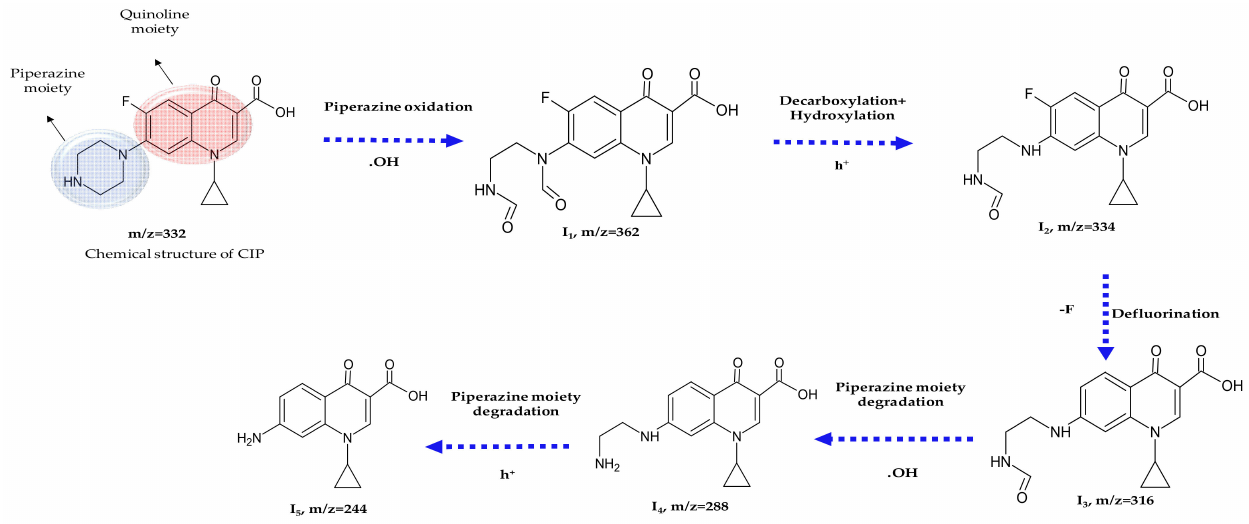
Figure 8. Possible pathway for the CIP